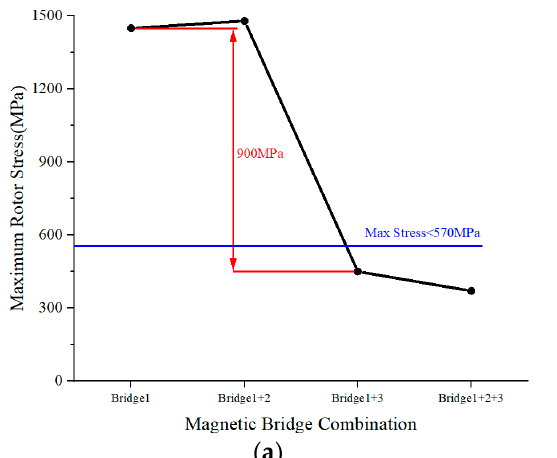
( c ) Figure 11. Motor electromagnetic characteristics with different bridge 1 width: ( a ) output torque, ( b ) torque ripple; ( c ) rotor core loss. ( a ) ( c ) Figure 12. Motor electromagnetic characteristics with different bridge 3 width: ( a ) output torque, ( b ) torque ripple, ( c ) rotor core loss. Magnetic bridge 1 is a tangential magnetic bridge, which mainly affects motor elec- tromagnetic characteristics. A narrow magnetic bridge 1 will cause serious saturation at the magnetic bridge, leading to a rotor flux leakage increase. More permanent magnet flux